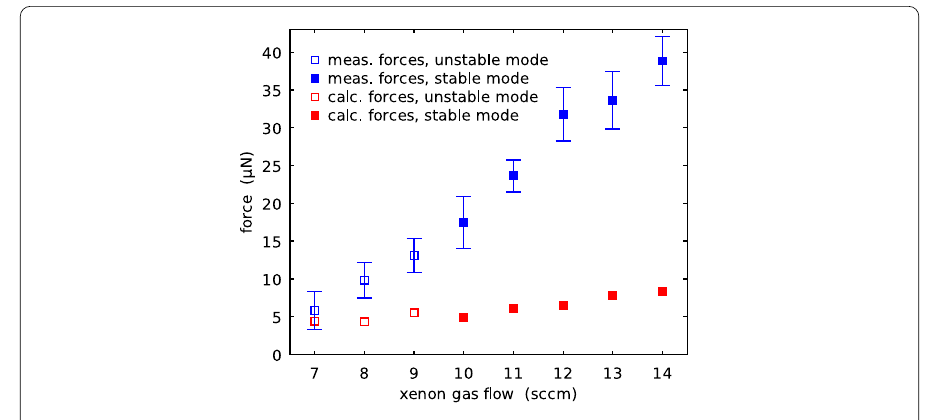
Figure 7 Flow-dependent measurement of forces at a fixed Hall thruster acceleration voltage of 200 V. Note the two operating modes depending on the gas flow. The calculated forces are based on the measured currents onto the probe